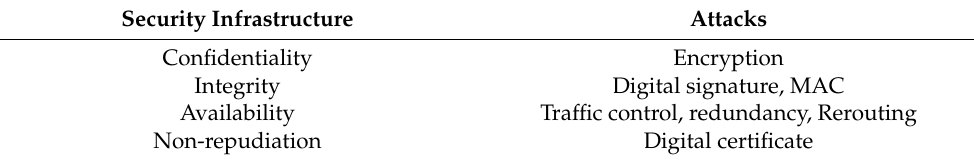
Table 2. WSNs protection